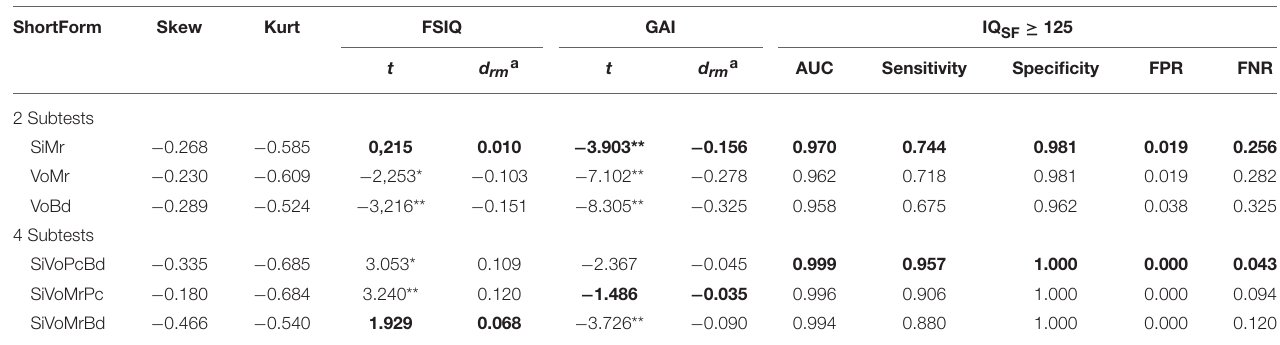
TABLE 5 | Performance analysis of three best 2- and 4-subtests WISC-IV short-forms.